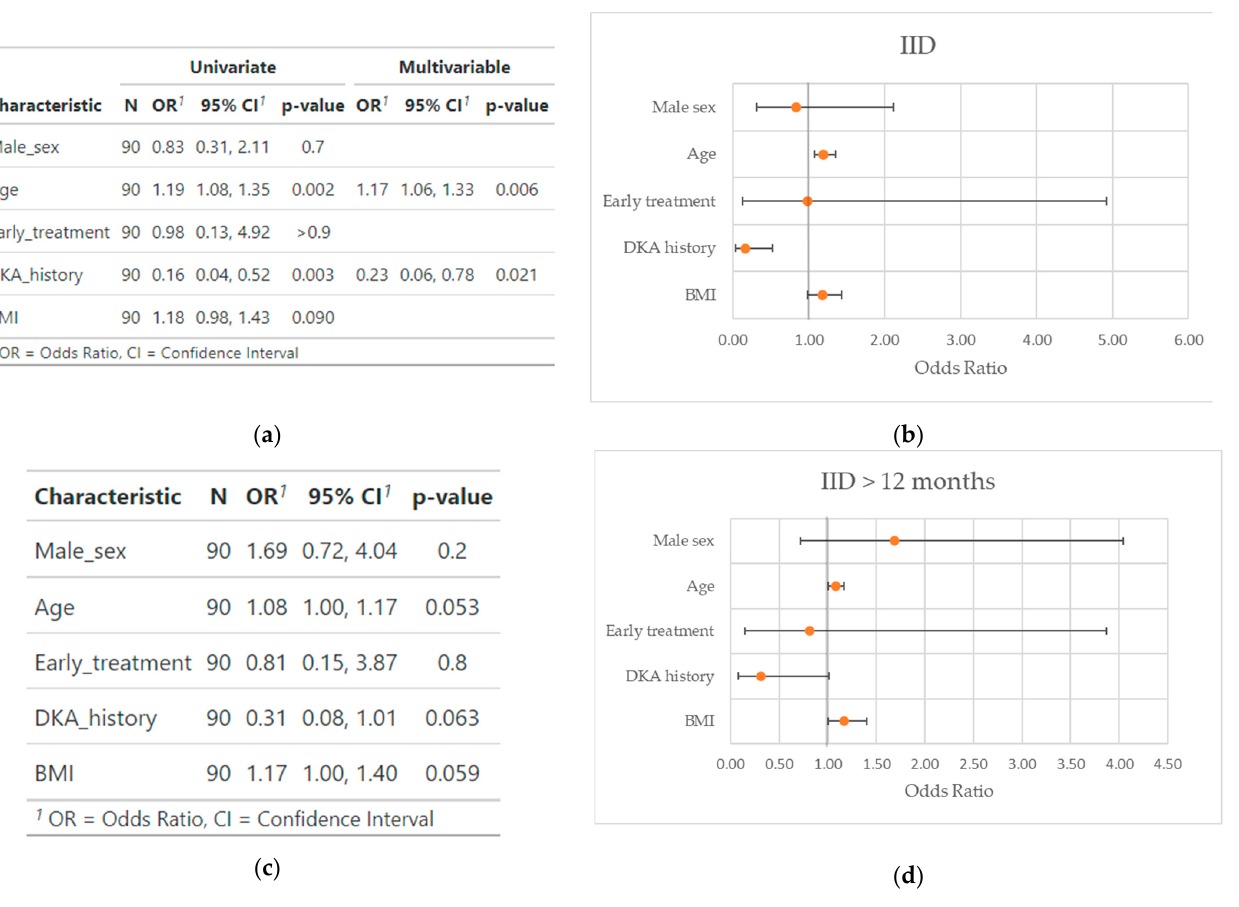
Figure 1. Odds ratio, 95% confidence interval and statistical significance of the patient characteristics for the achievement of insulin independence ( a ) and maintaining it for >12 months ( c ); respective forest plots ( b , d ). Forest plots represent the results of the univariate analysis. Table 2. Characteristics of patients enrolled in the clinical trials selected for statistical analysis.